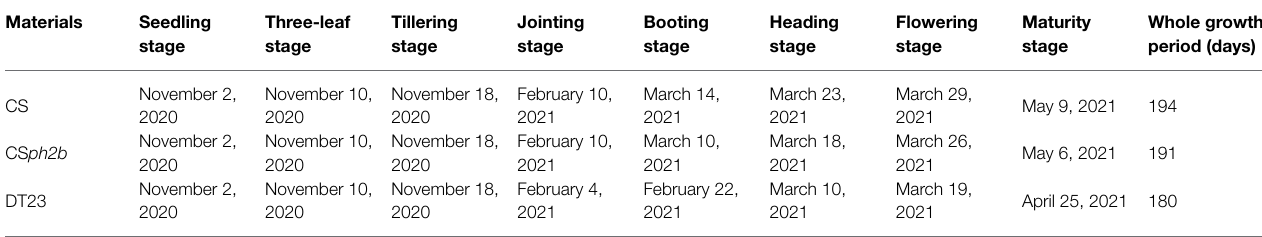
TABLE 2 | Growth period statistics of CS, CS ph2b , and DT23 in the field.